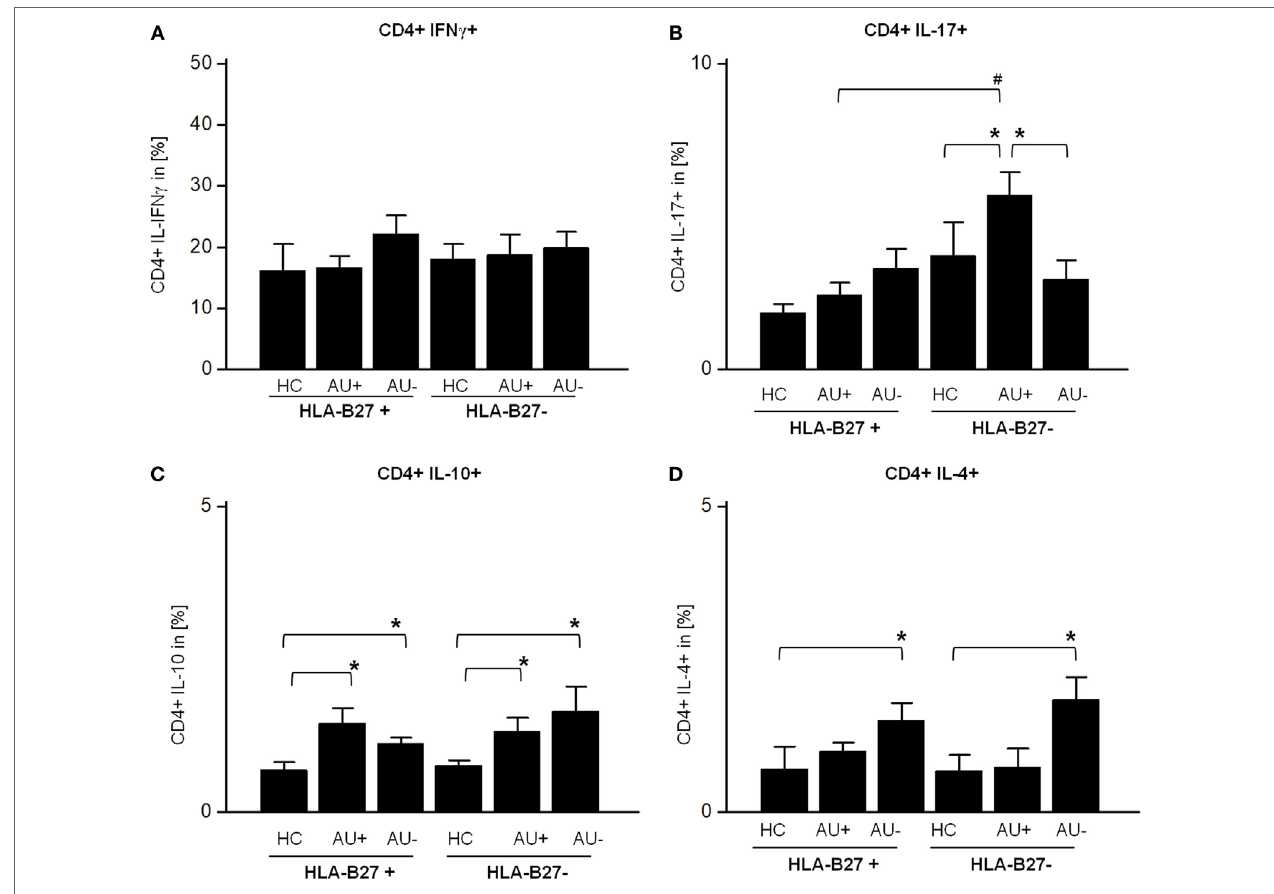
FigUre 2 | Frequency of (a) CD4 + IFN γ+ , (B) CD4 + IL-17A + , (c) CD4 + IL-10 + , and (D) CD4 + IL-4 + T-cells in peripheral blood of HLA-B27-positive/-negative healthy controls (HCs), and patients with active (AU + ) and inactive (AU − ) anterior uveitis analyzed by flow cytometry (* p < 0.05; Kruskal–Wallis test; # p < 0.05; Mann–Whitney U